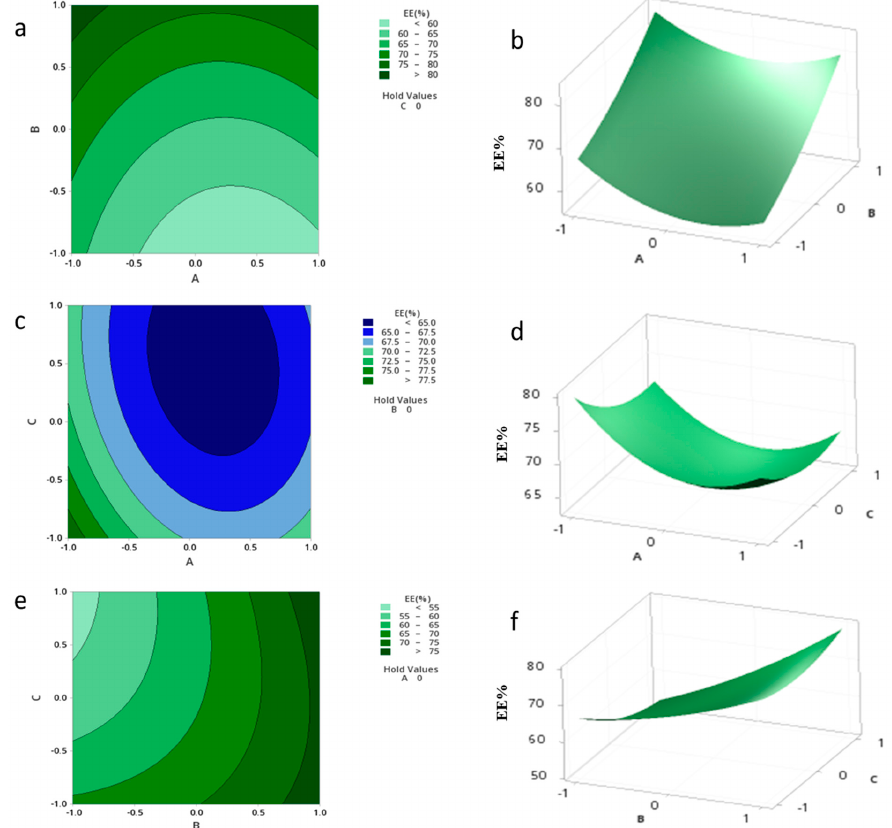
Figure 7. Contour plots ( a , c , e ) and Surface plots ( b , d , f ) showing the effect of variables (A–C) on the EE% of the NPs.